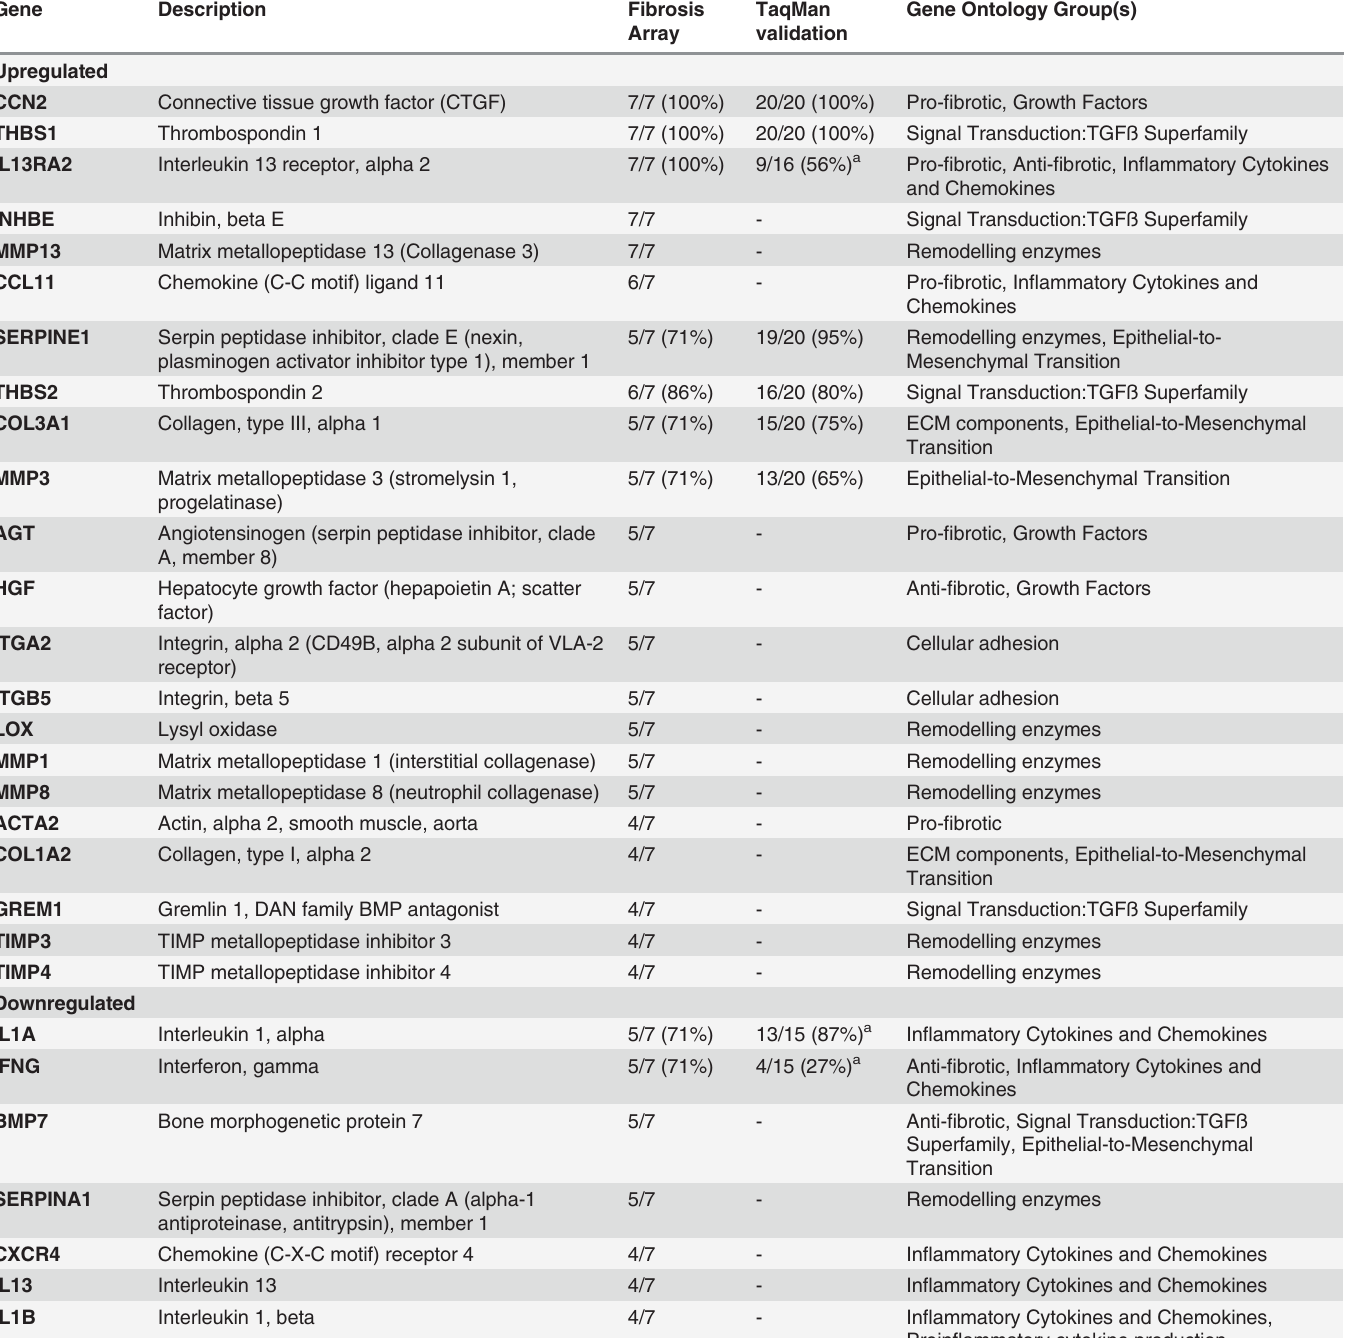
Table 2. Differential gene expression ( (cid:1) 2 fold) in failed AGV capsules determined by fibrosis array and validated by TaqMan gene expression assays.